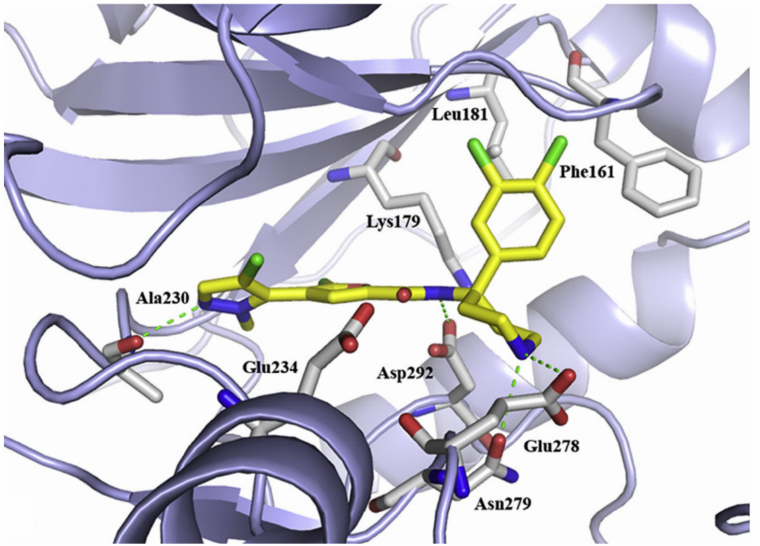
Figure 4. In silico binding interactions of compound 1 with Akt1 kinase crystal structure